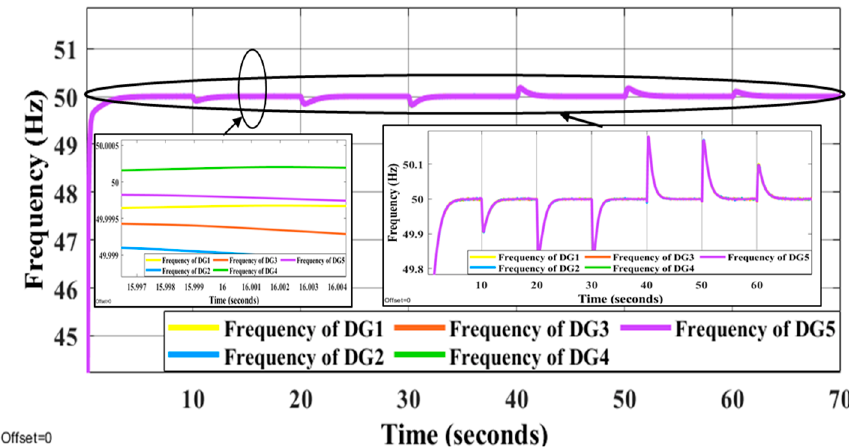
Figure 13. Frequency patterns of all DGs under using proposed online method under the step changes in loads.